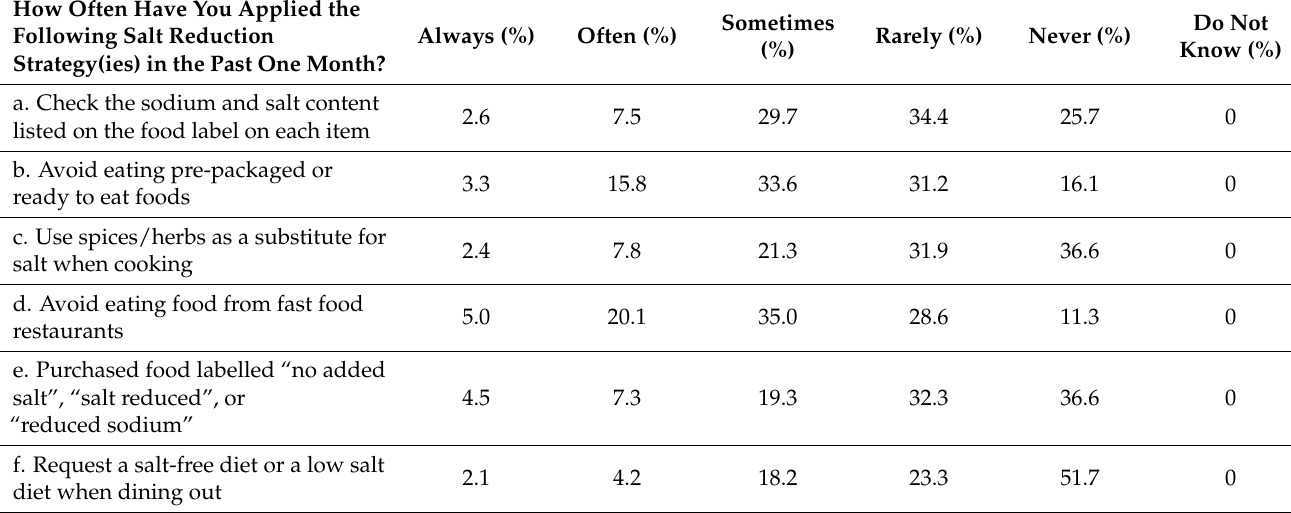
Table 4. Dietary salty reduction